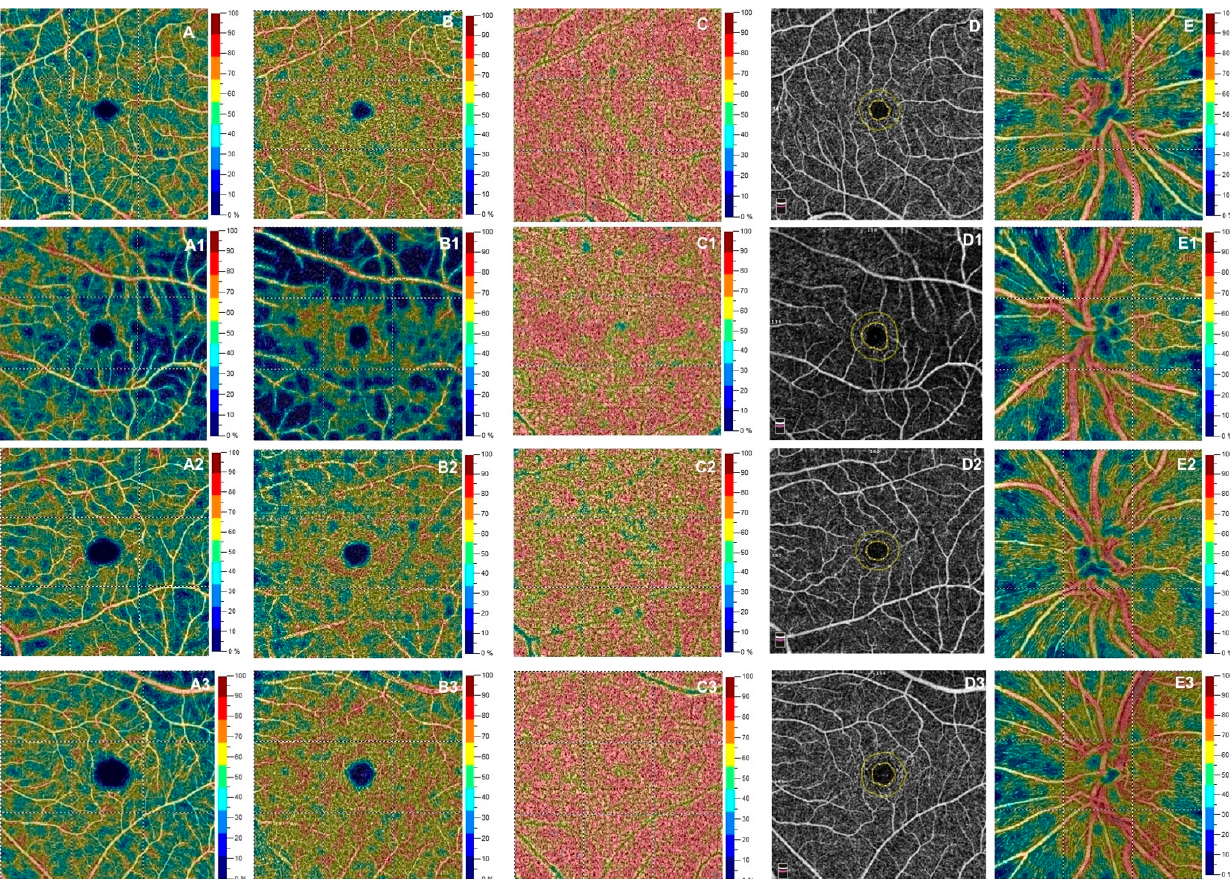
Figure 2. Top Row — Right eye of a 44 years-old male healthy subject reveals at OCT Angiography (OCTA) normal vessel density in superficial capillary plexus (SCP) ( A ), deep capillary plexus (DCP) ( B ), choriocapillaris (CC) ( C ), Fovea Avascular Zone (FAZ) area ( D ) and radial peripapillary capillary (RPC) ( E ). Second Row — Left eye of a 43 years-old female patient with Transfusion Dependent Thalassemia shows a reduction of vessel density in SCP ( A1 ), DCP ( B1 ), CC ( C1 ), RPC ( E1 ) and an increase of FAZ area ( D1 ) respect to the healthy subjects and other groups. Third Row — Left eye of a 45 years-old female patient with Non-Transfusion Dependent Thalassemia shows absence of changes in vessel density of SCP ( A2 ), CC ( C2 ), FAZ area ( D2 ) and RPC ( E2 ) except for DCP ( B2 ) that turns to be decreased respect to β -thalassemia minor and controls. Bottom Row — Left eye of a 44 years-old male patient with β -thalassemia minor shows absence of changes in vessel density of SCP ( A3 ), DCP ( B3 ), CC ( C3 ), FAZ area ( D3 ) and RPC ( E3 ).